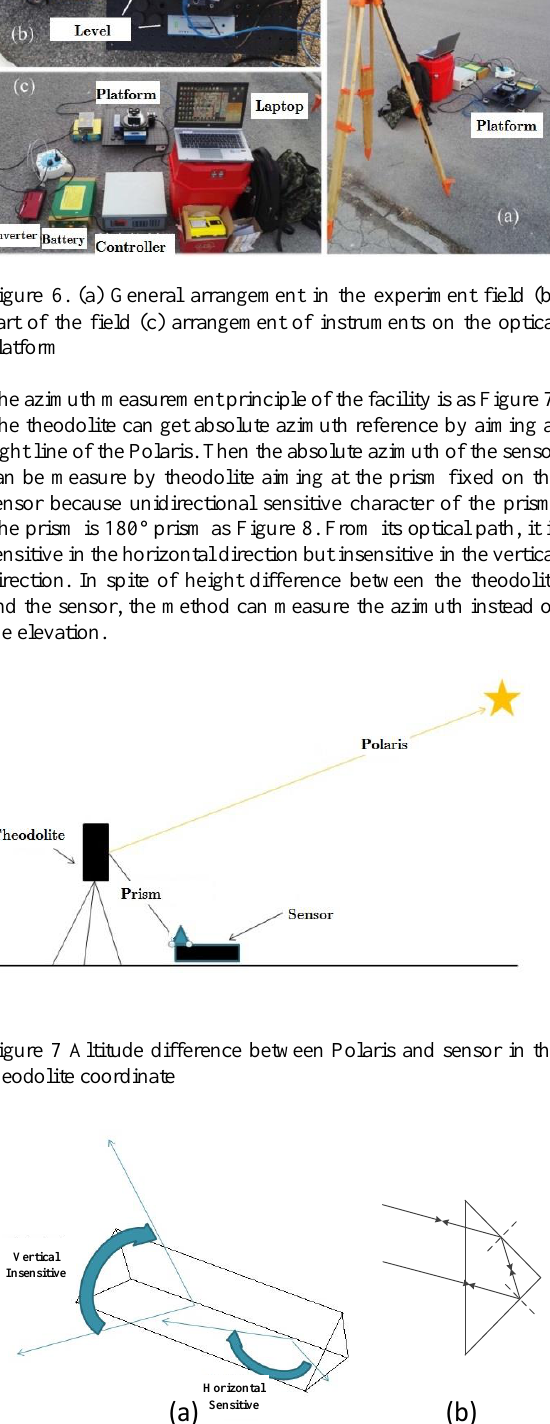
Figure 8. (a) Unidirectional sensitive feature of 180° prism (b) optical path in the surface perpendicular to the ridge of the prism The azimuth and elevation of the Polaris can calculate